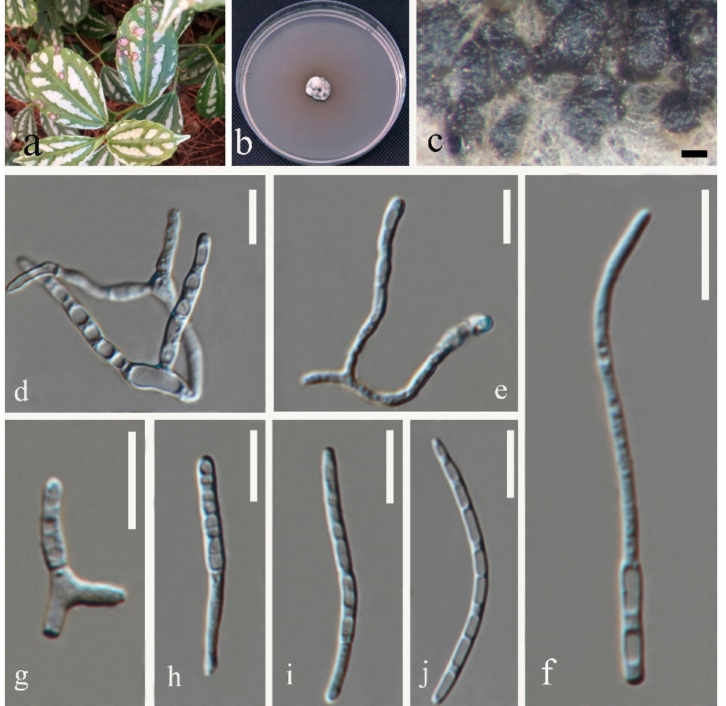
Figure 5. Septoria longipes (GUCC 2131.1) ( a ) Leaf spot symptoms on the host. ( b ) Colony on PDA. ( c ) Conidiomata on PDA culture. ( d – g ) Conidiophores, Conidiogenous cells and conidia. ( h – j ) Conidia. Scale bars: ( c ) = 20 µ m. ( d – j ) = 10 µ